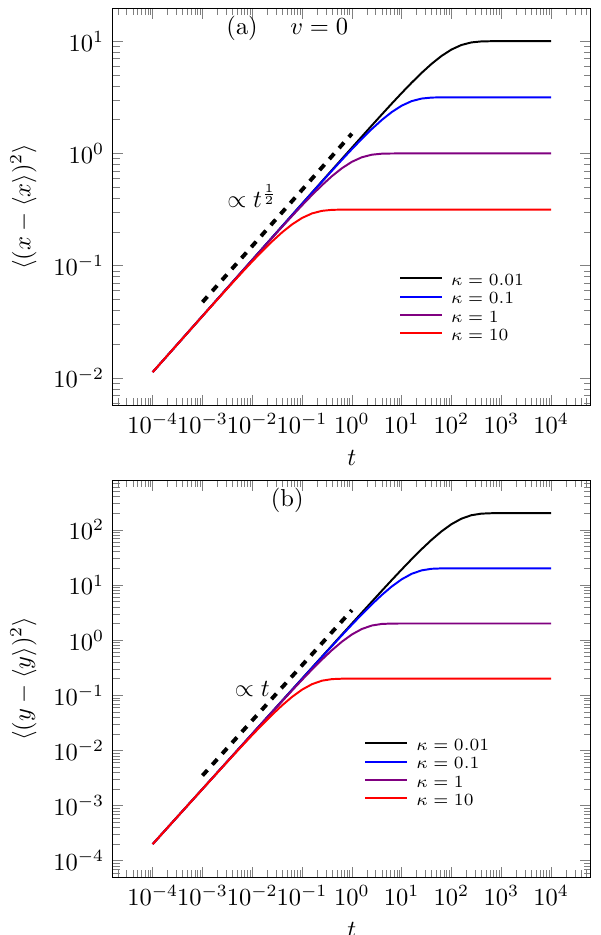
Figure 4. These figures represent time evolution of MSD behaviors in Equations (23) and (24) to static stochastic resetting case, i.e., v = 0. Figure ( a ) represents the MSD on x -axis and Figure ( b ) represents the MSD on y -axis. Both figures consider the parameter valuers as follow